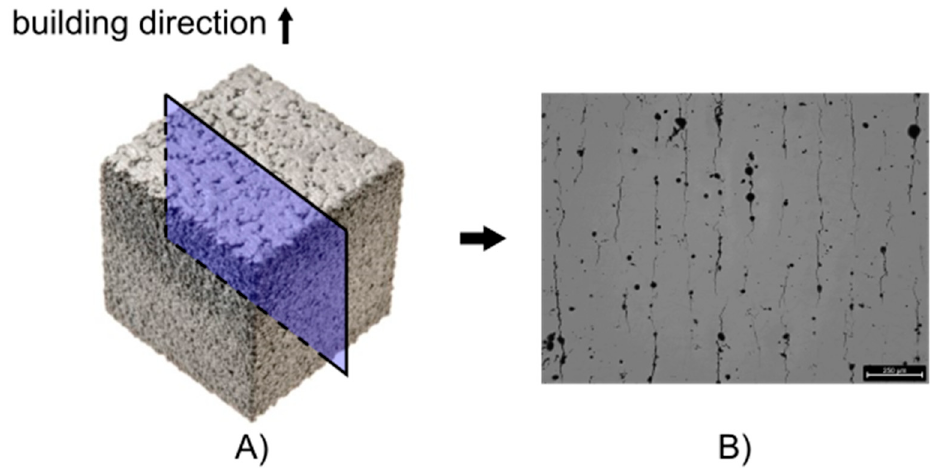
Figure 1. ( A ) Cubical specimens, 10 × 10 × 10 mm 3 , were produced with LPBF and cut perpendicular to the building direction. ( B ) The cross sections were cut, polished, and captured with a light microscope, in order to reveal the solidification cracks parallel to the building direction.